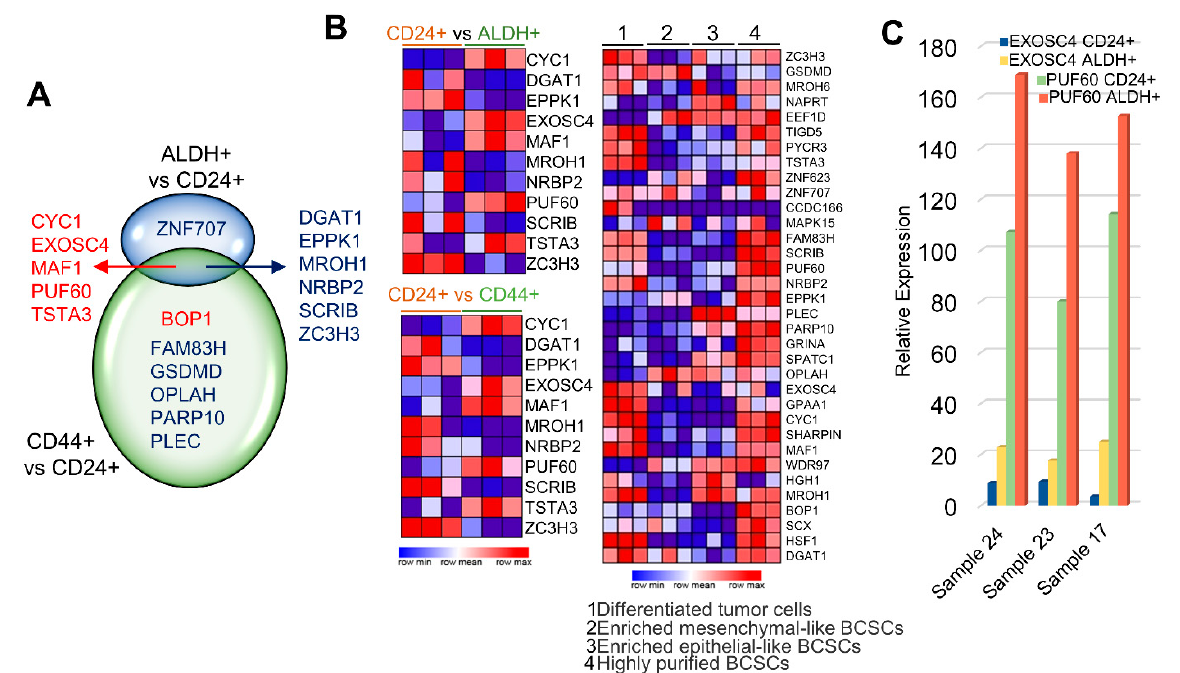
Figure 5. CanCord34 genes in cancer stem cells. ( A ) Venn diagram representing the CanCord34 genes reported to be involved in the stem cells. Upregulated genes are represented in red, whereas downregulated genes are in blue. ( B ) Heatmap representation of the CanCord34 gene expression in ALDH+ vs. CD24+ cell clusters (top left), CD24+ vs. CD44+ cells, and differentiated tumor cells, enriched mesenchymal-like BCSCs, enriched epithelial-like BCSCs, and highly purified BCSCs. The image was constructed using the heatmap package of Gene Patterns. ( C ) Bar chart representing the expressions of EXOSC4 and PUF60 in the sample sets of ALDH+ and CD24+ cells.